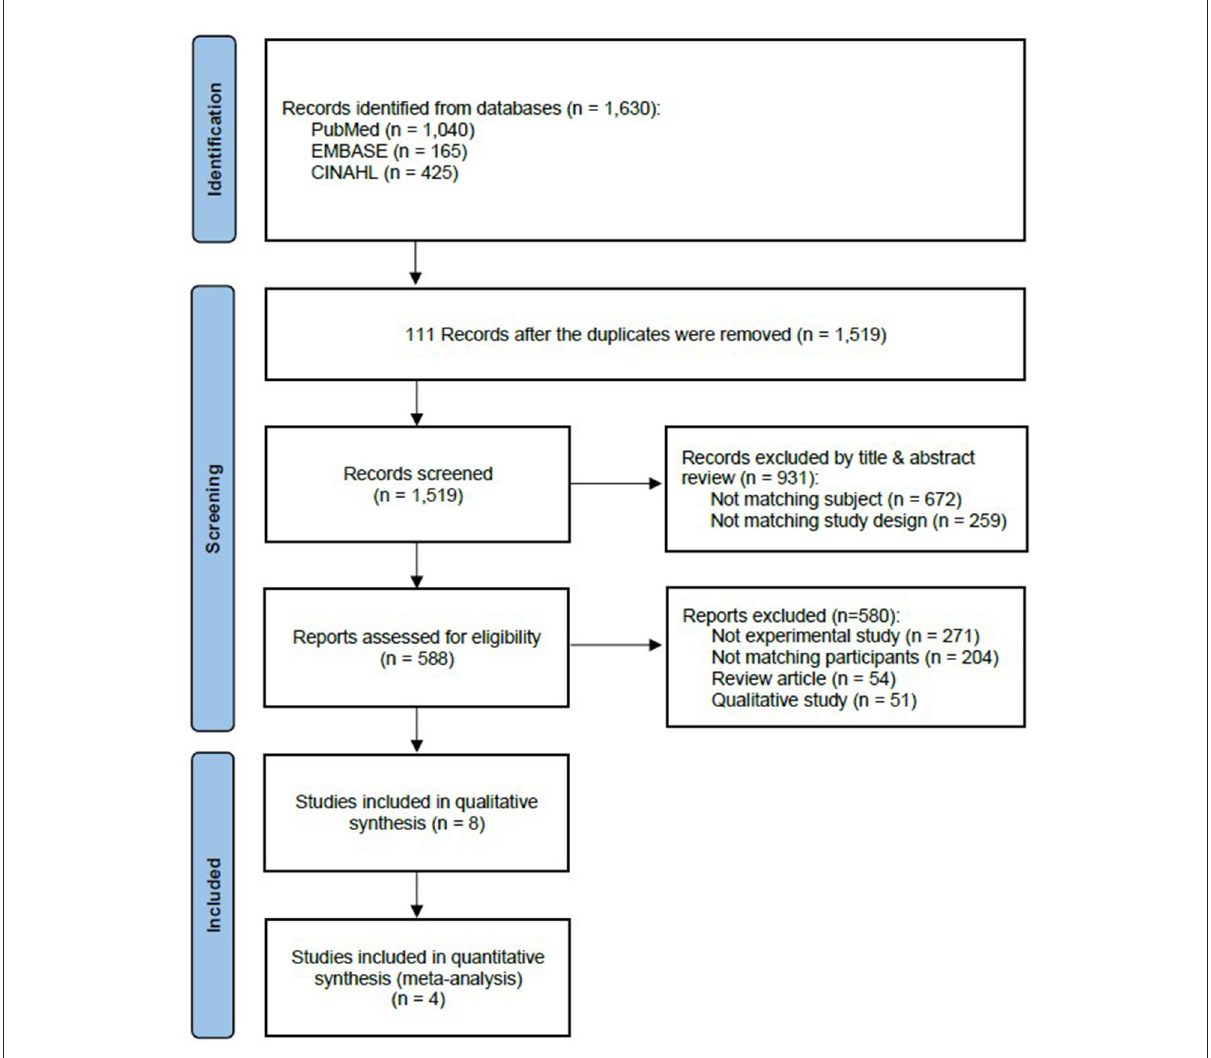
FIGURE1 PRISMA flow diagram of the study screening